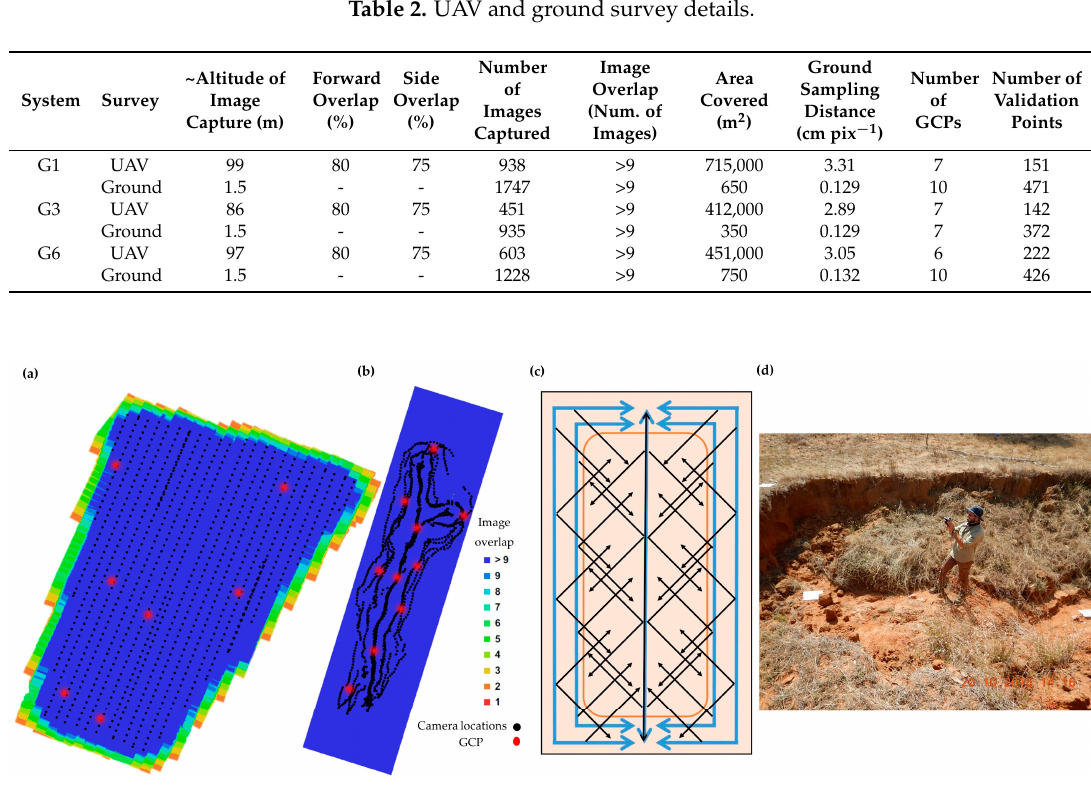
Figure 4. Camera and GCP locations and image overlap of ( a ) UAV survey of G1; and ( b ) ground survey of G1 gully; ( c ) theoretical path of photographer (blue arrows) and direction of image capture (black arrows) during ground survey. The brown line diagrammatically defines the gully edge. ( d ) Photographer during a ground survey.